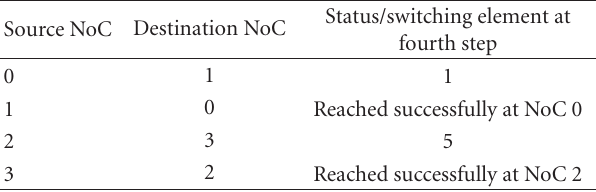
Table 17: Intermediate SE information while data is moves from source NoC to destination NoC (in between some information has been reached to the desired destination successfully) at fourth step of best case.